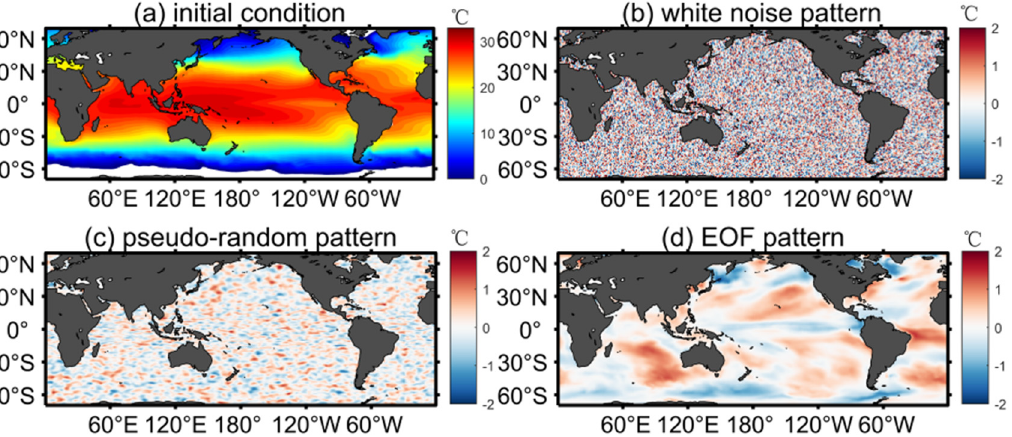
Figure 1. ( a ) SST of the initial condition which is derived from the model integrations carried out by CESM from a cold start for 100 years. The distribution of the error of the SST generated by the above three methods: ( b ) white noise perturbation, ( c ) pseudo-perturbation, and ( d ) EOF perturbation.